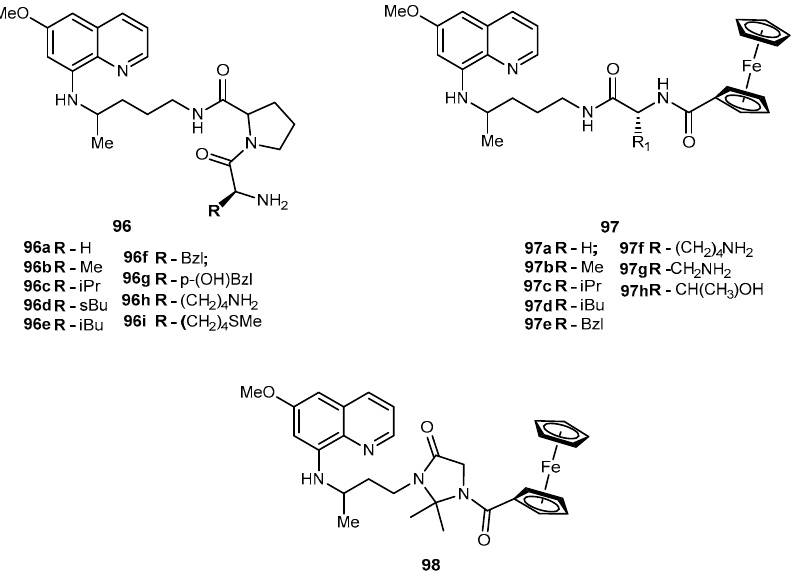
Figure 40. Peptidomimetic derivatives, imidazolidin-4-one derivatives and Ferrocene derivatives of 4 evaluated for Leishmania infantum .